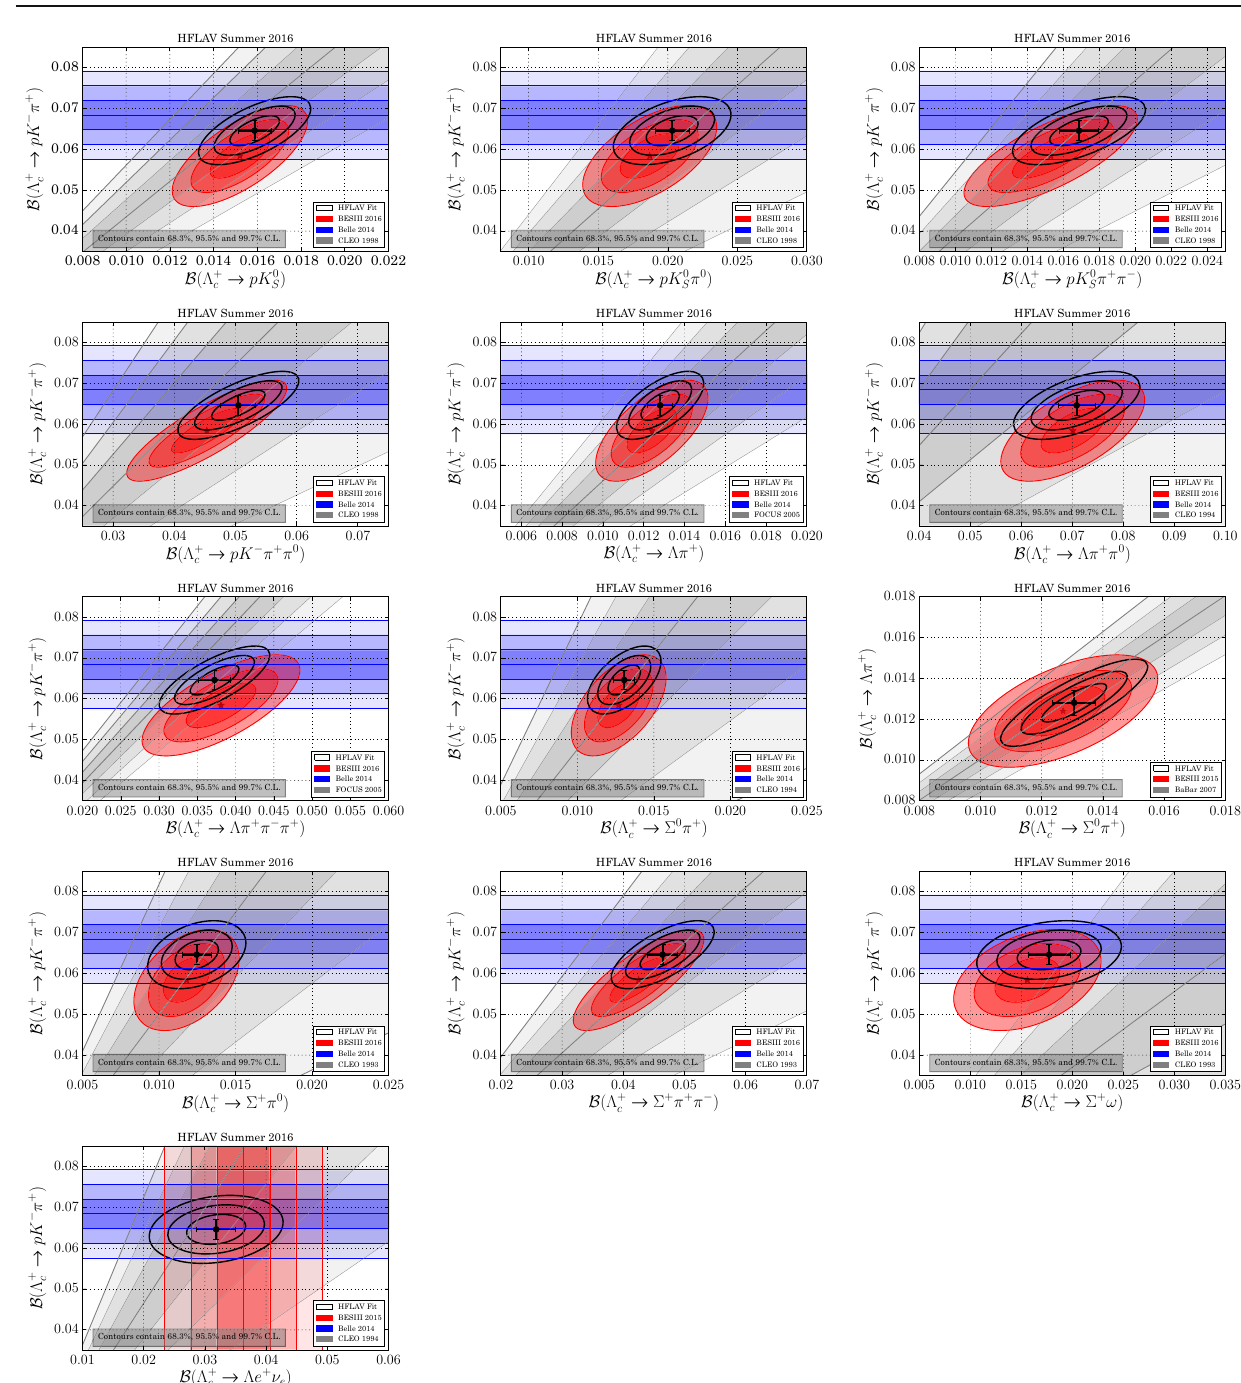
Fig. 215 Plots of all individual measurements and the fitted averages. Individual measurements are plotted as bands ( ellipses ) showing their ± 1 σ , ± 2 σ , and ± 3 σ ranges. The best fit value is indicated by a cross